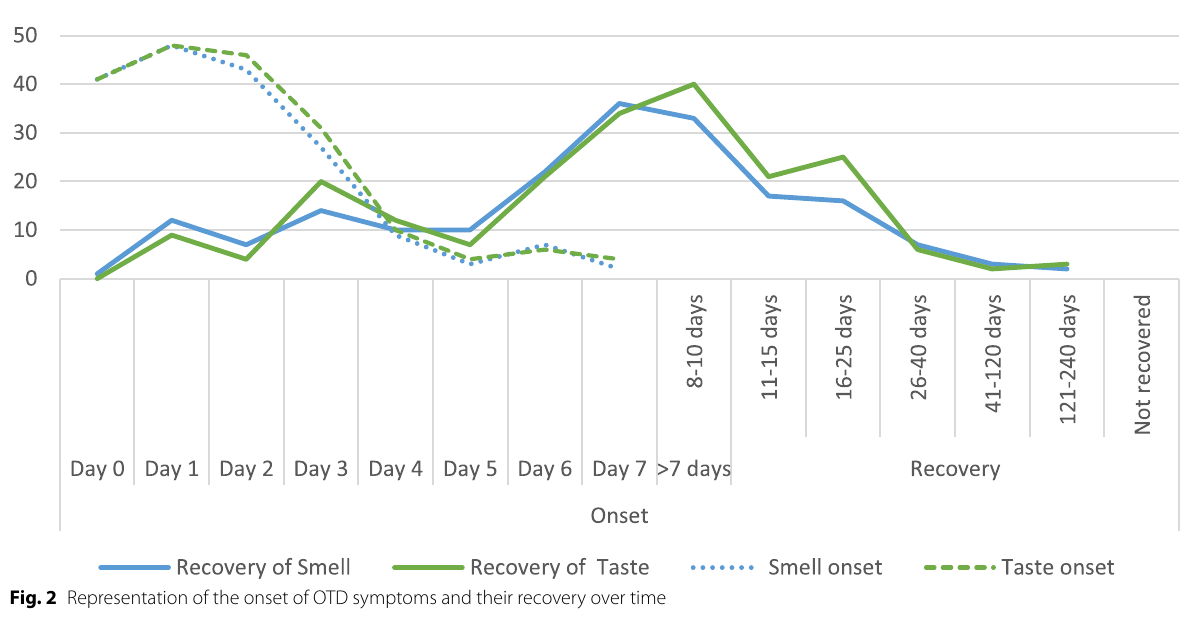
Table 7 Correlation of recovery time of OTD symptoms with each other and other common symptoms Recovery time No. of Test Strength of Significance patients ( n ) association Co-relation of recovery time Smell and taste 160 Pearson correlation coefficient r 0.91 p < =